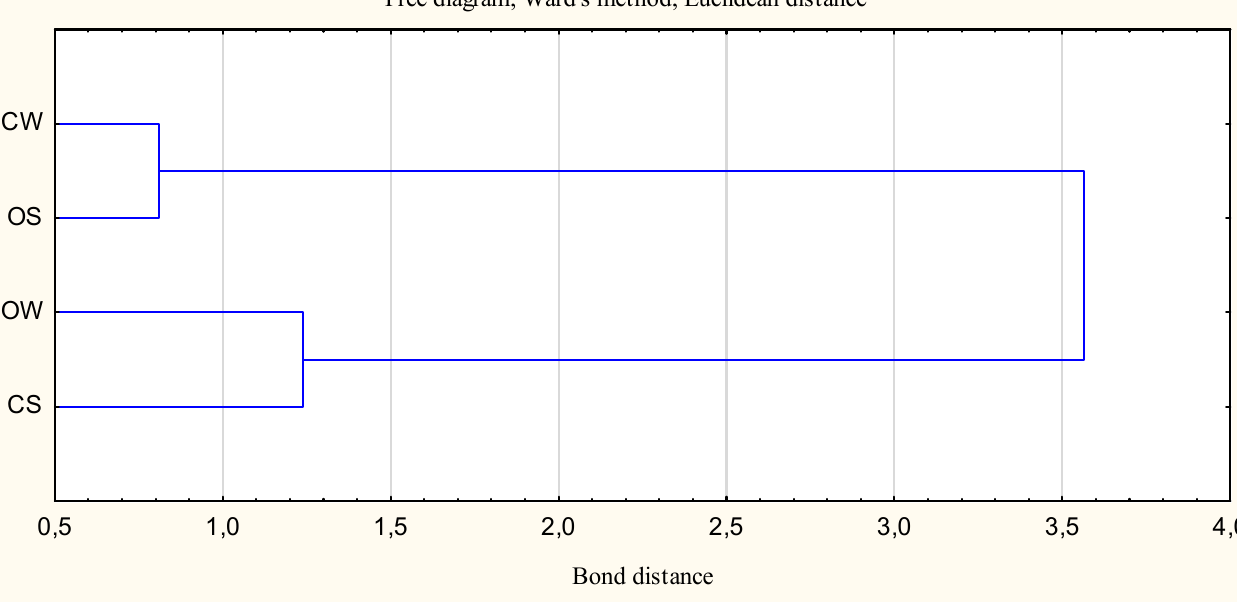
Figure 2. Tree diagram—Ward’s dendogram for AcPh and AlPh.